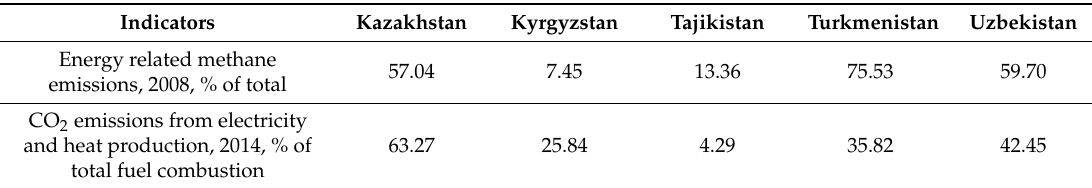
Table 5. Energy Sectors’ Environmental Footprint (Source: author, based on World Bank data).